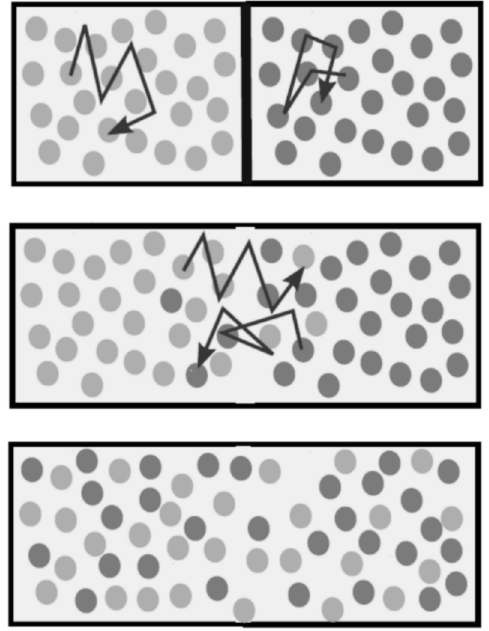
Figure 5. Diffusion of molecules of two types after the removal of an obstacle